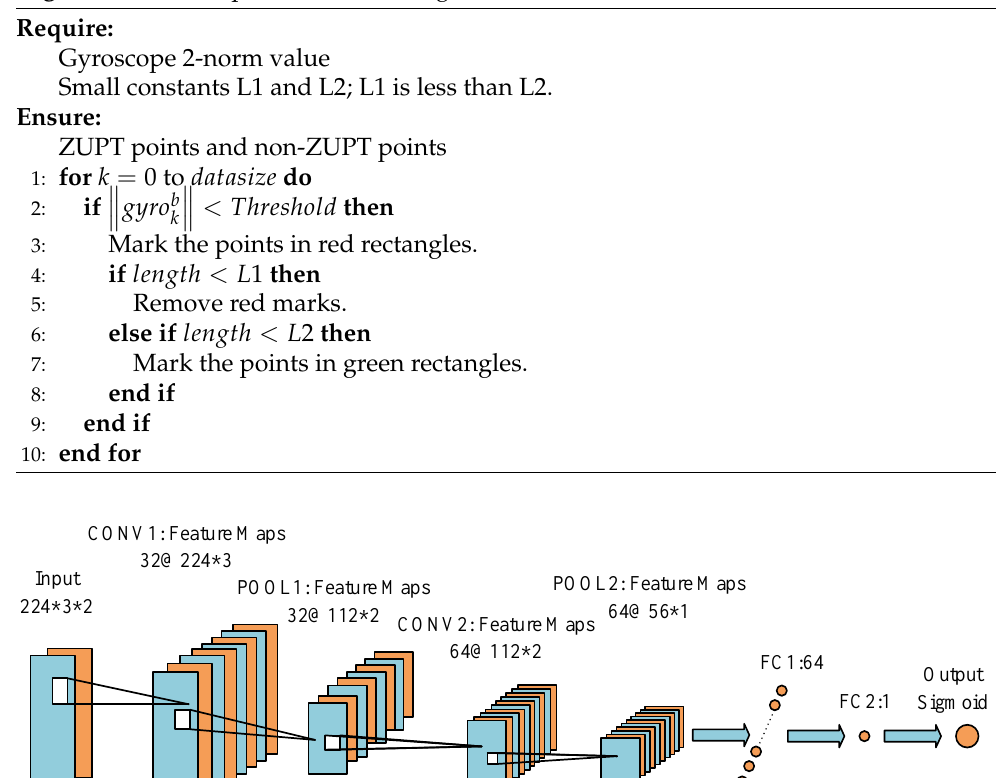
Algorithm 1 ZUPT points’ selection algorithm.